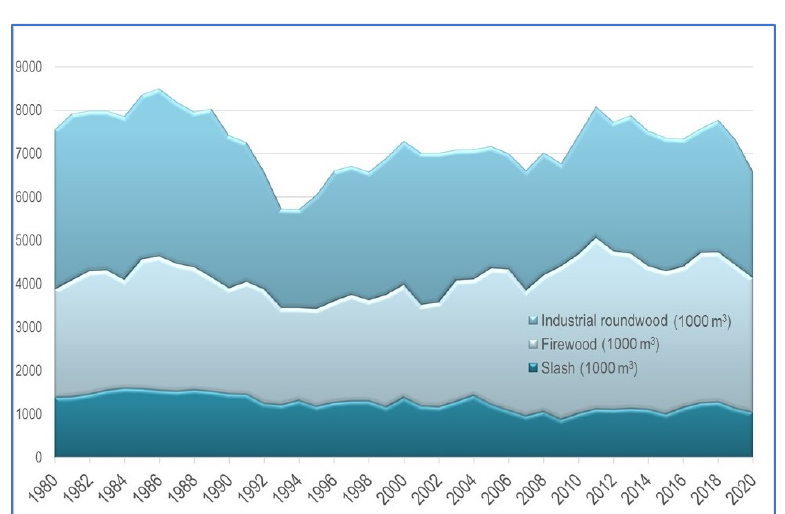
Figure 1. Amount of wood removal and slash in time period of 1980–2020.